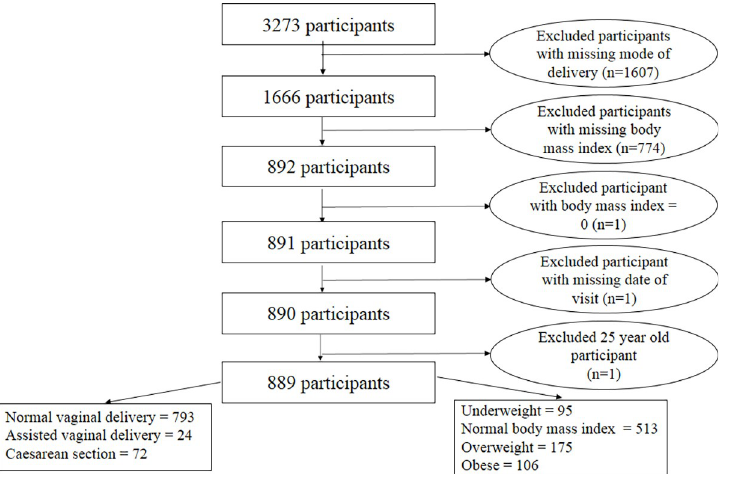
Fig 1. Flowchart showing the study population and selection of study